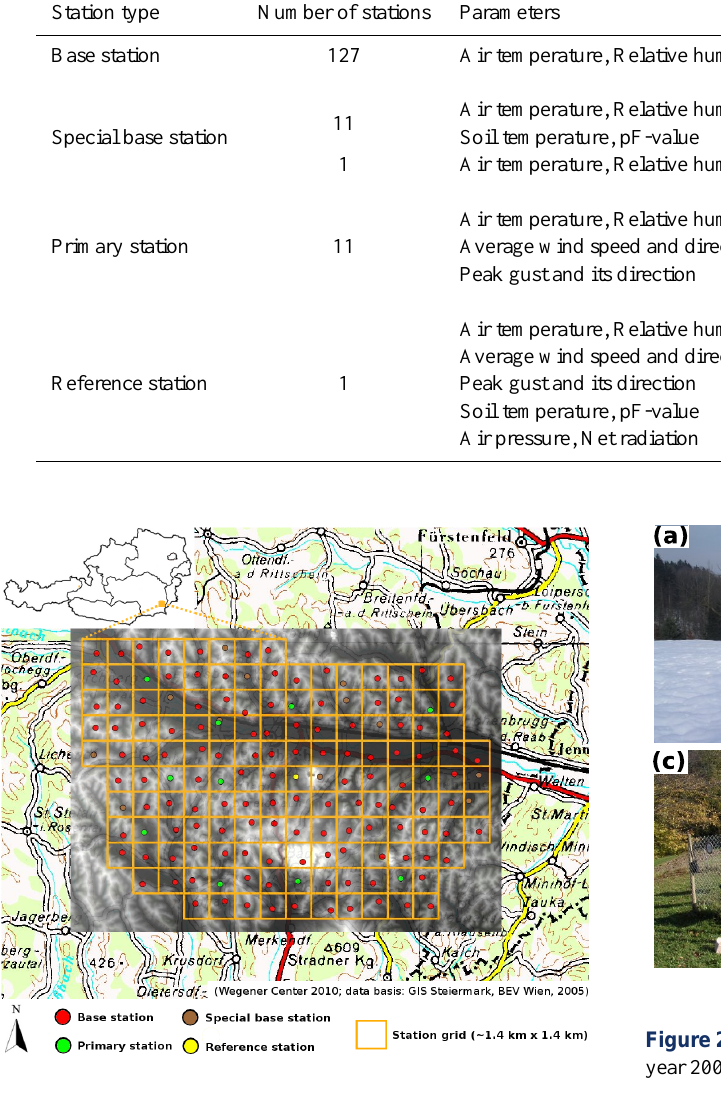
Figure 1. The WegenerNet study region (orographic map) in Aus- tria and the station locations in the station grid.